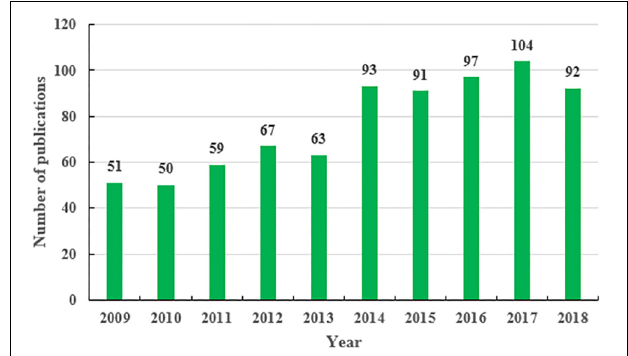
FIGURE 1 | Annual output of Angelica sinensis research.